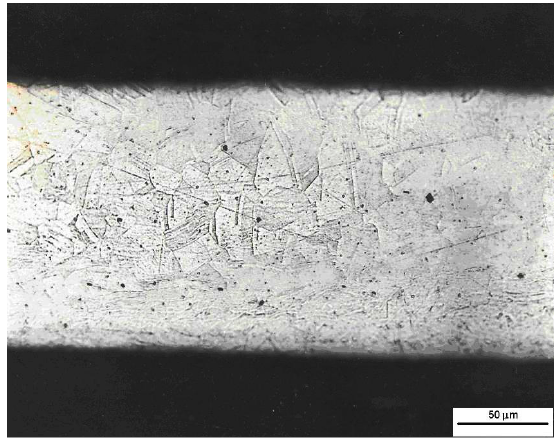
Figure 6. The strip blank KT section.